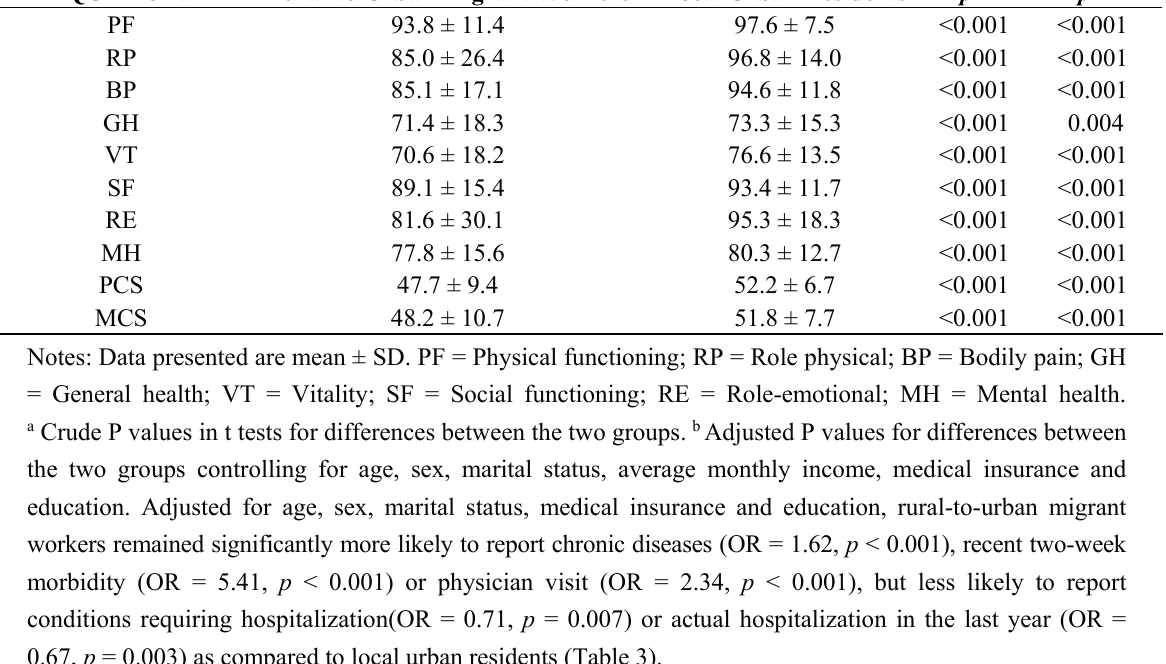
Table 2. Health related quality of life (HRQOL) in rural-to-urban migrant workers versus local residents. HRQOL Domain Rural-to-Urban Migrant Workers